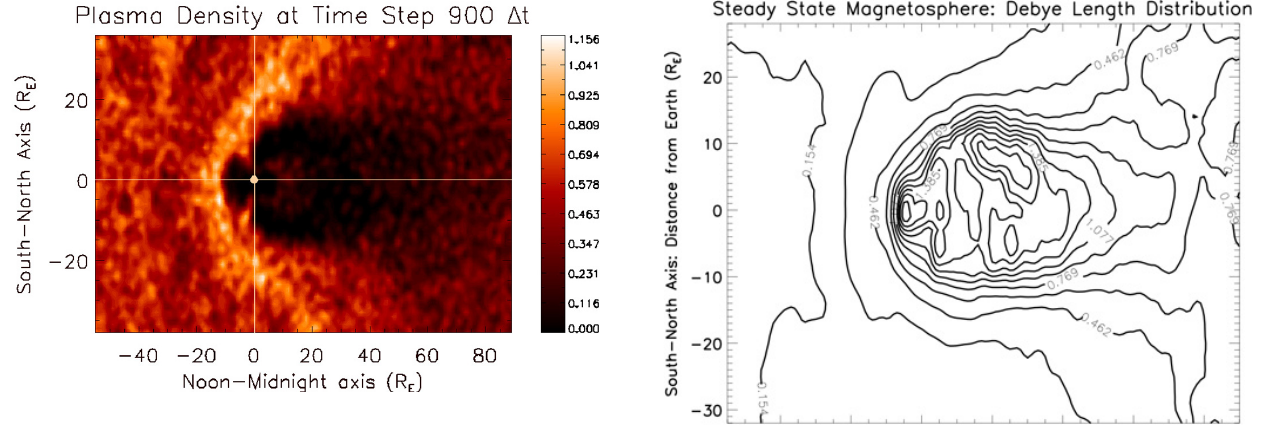
Fig. 1a. Plasma density distribution for unperturbed case taken at 900 1t shown in x-z plane and Earth’s position is centered at [0, 0, 0] R E corresponding to [60, 52, 53] R E in the simulation box.